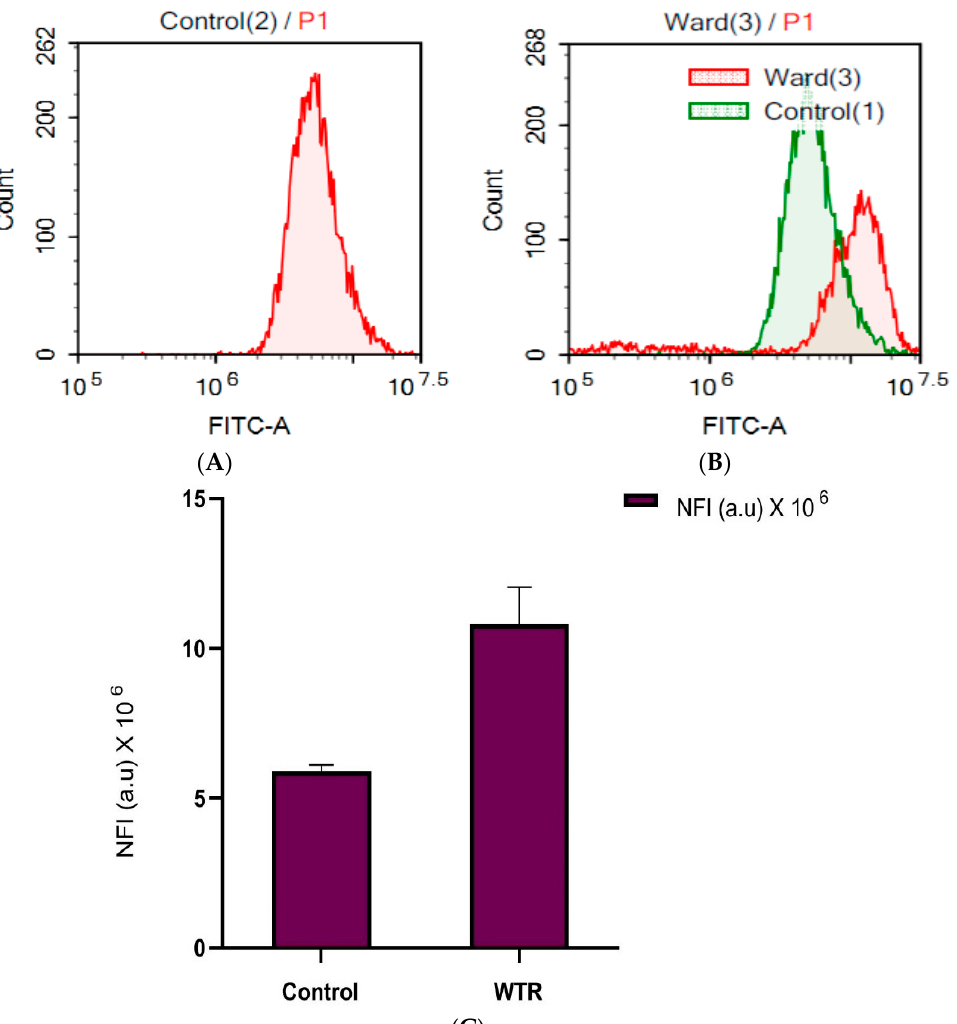
Figure 6. Autophagic cell death assessment in HepG2 cells ( A ) after exposure to waste of Taif rose ( Rosa damascene Mill var. trigentipetala ) for 48 h and being stained with acridine orange: ( A ) control, ( B ) WTR, and ( C ) statistical analysis for NFI.